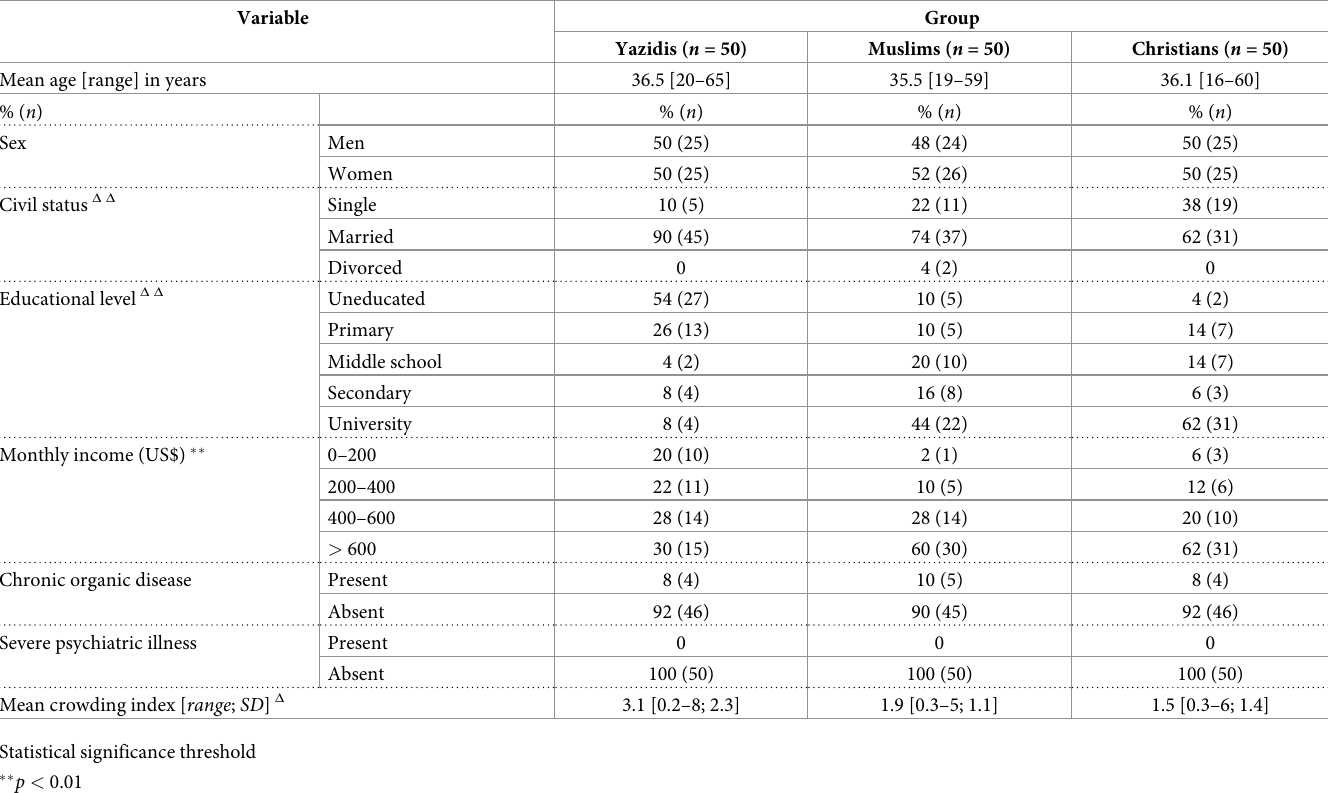
Table 1. Sociodemographic characteristics of participants by religious